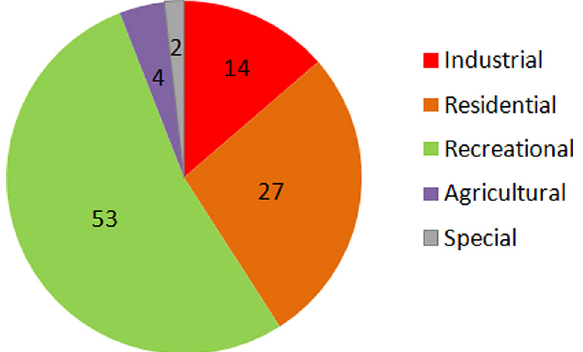
Fig. 11. Distribution of functional areas on the territory of